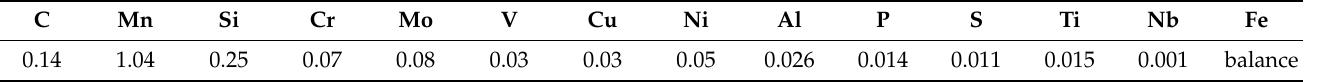
Table 10. Percentage chemical composition of API 5L X60 steel